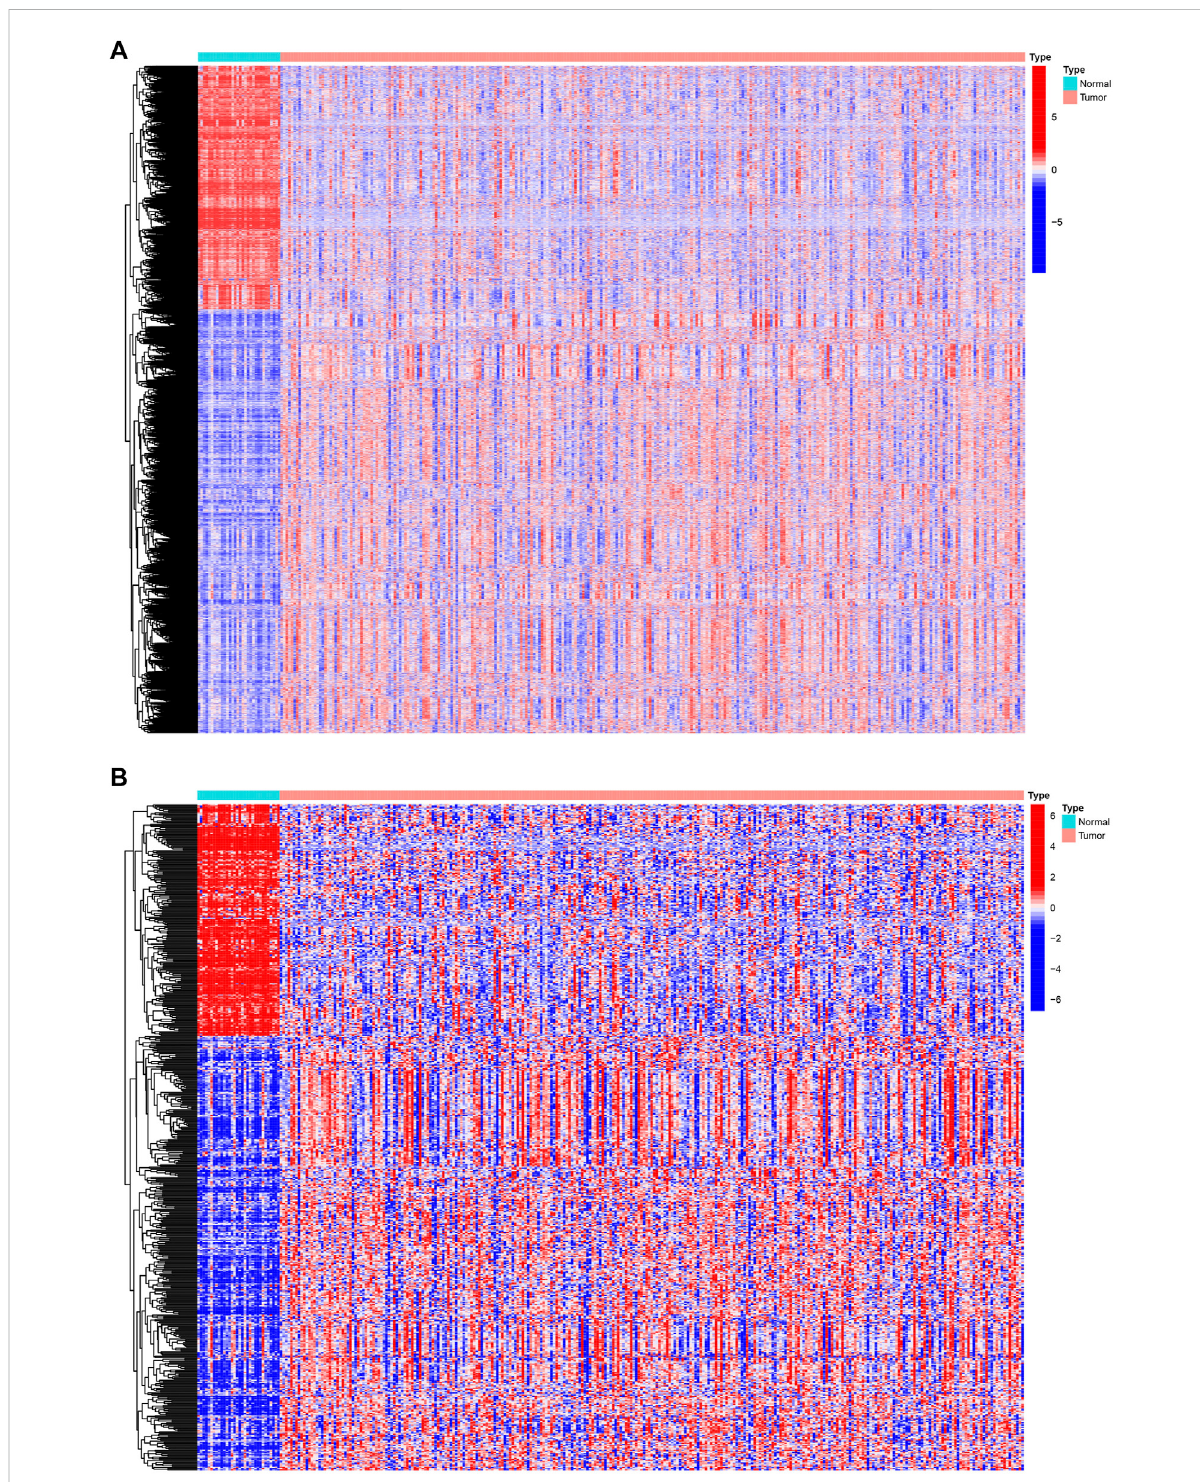
FIGURE 1 Differentially expressed IRGs. The heatmap (A) of differentially expressed genes in PRCC samples, compared to adjacent normal samples. The heatmap (B) and of differentially expressed IRGs. Red represents higher expression genes, blue represents lower expression genes, black represents same expression genes (fold change > 1.5 and p < 0.05). IRGs, immune-related genes; PPRC, papillary renal cell